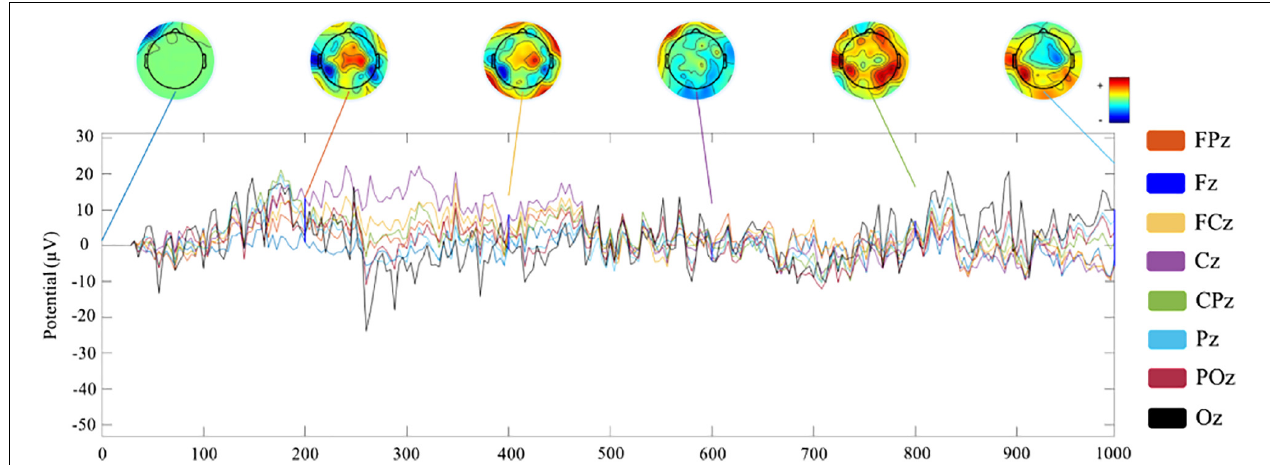
FIGURE 6 | Channel waveform and topographic map of real-time neurofeedback training phase.